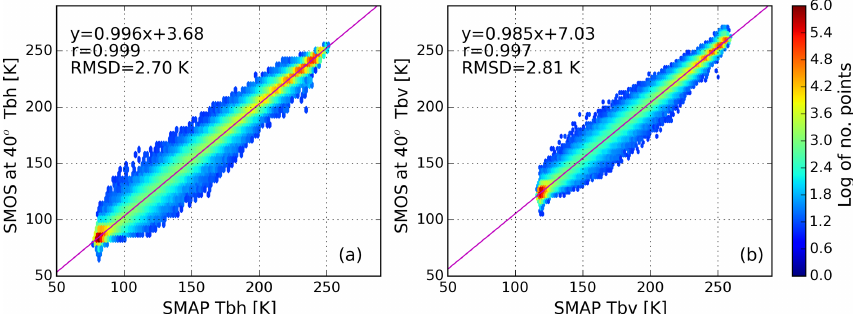
Figure 5. Logarithmic density plot of TB h (a) and TB v (b) data from SMAP and SMOS for the period 1 October to 31 December 2015. Magenta lines represent the linear regression between the two